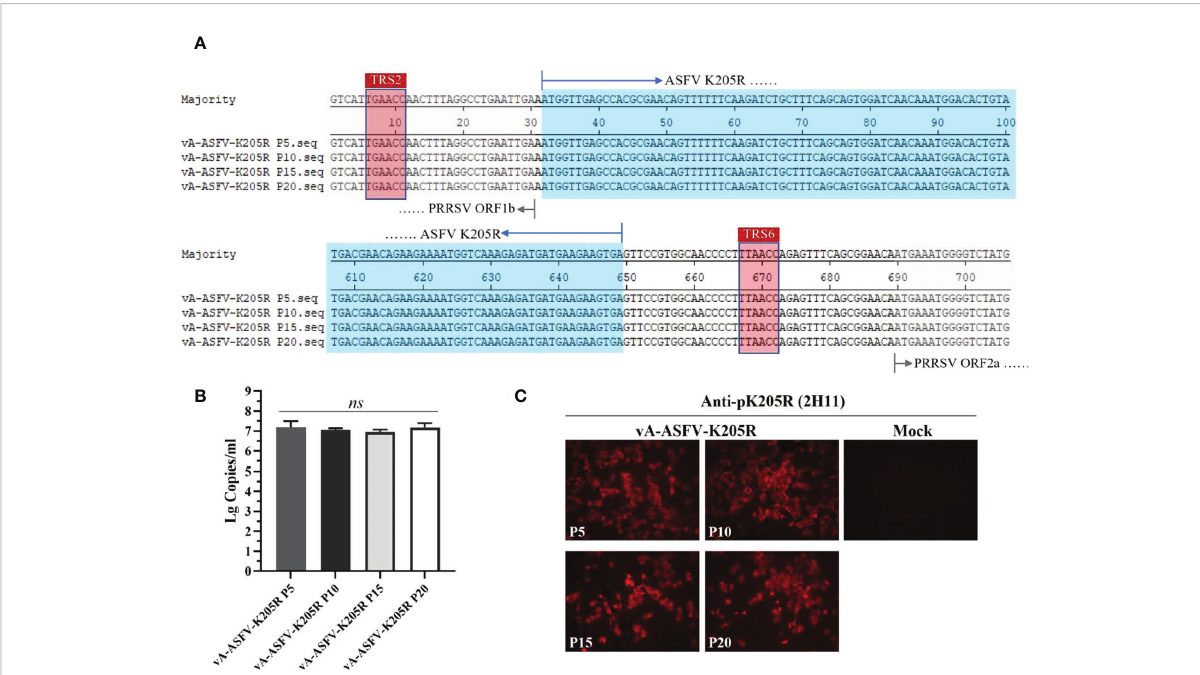
FIGURE 6 MARC-145 cells were infected by the recombinant virus vA-ASFV-K205R (P5, P10, P15, and P20 viral stocks). Cell culture supernatants were collected at 48 h post infection. (A) Sequence alignments to show the genetic stability of ASFV K205R gene (P5, P10, P15, and P20 viral stocks). The sequences of foreign gene were displayed in blue color. (B) The copy levels of K205R gene were detected in the recombinant PRRSVs (P5, P10, P15, and P20 viral stocks) by RT-qPCR. Data are presented as the mean ± standard deviation of three independent experiments. Statistical signi fi cance was analyzed using t -tests. ns , not signi fi cant. (C) The pK205R expression in the recombinant PRRSVs (P5, P10, P15 and P20 viral stocks) was detected using 2H11 by